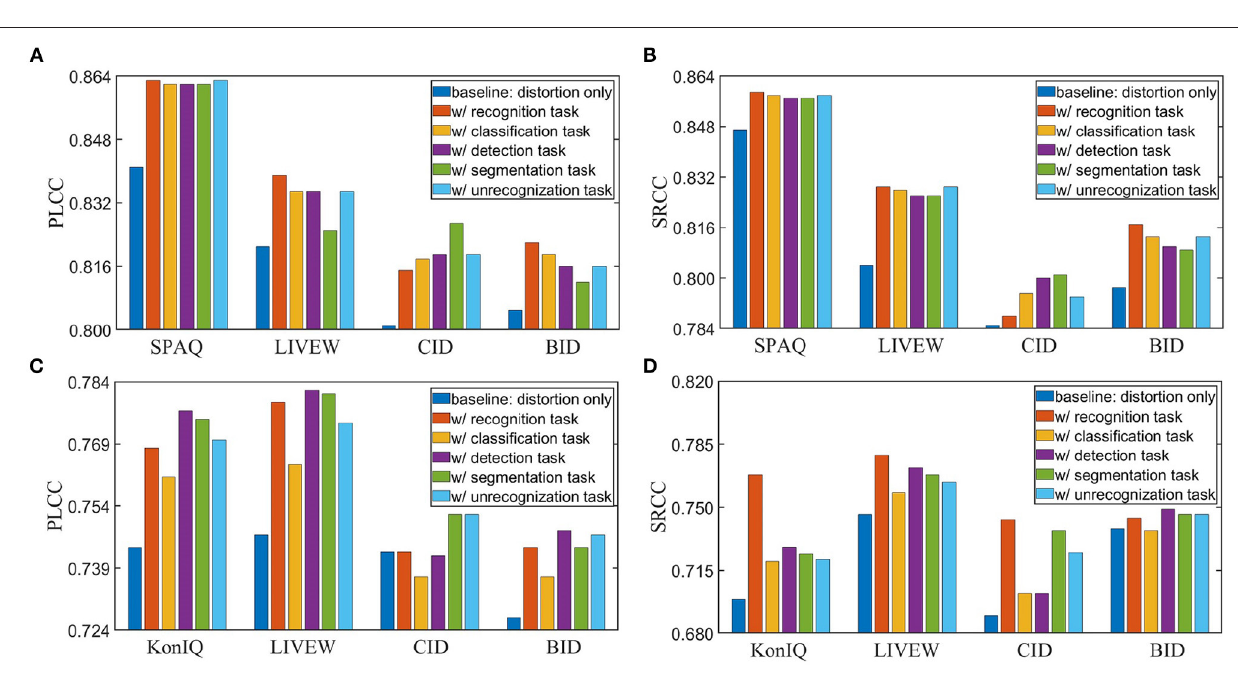
M parameters, the backbone of HyperNet), and ResNet101